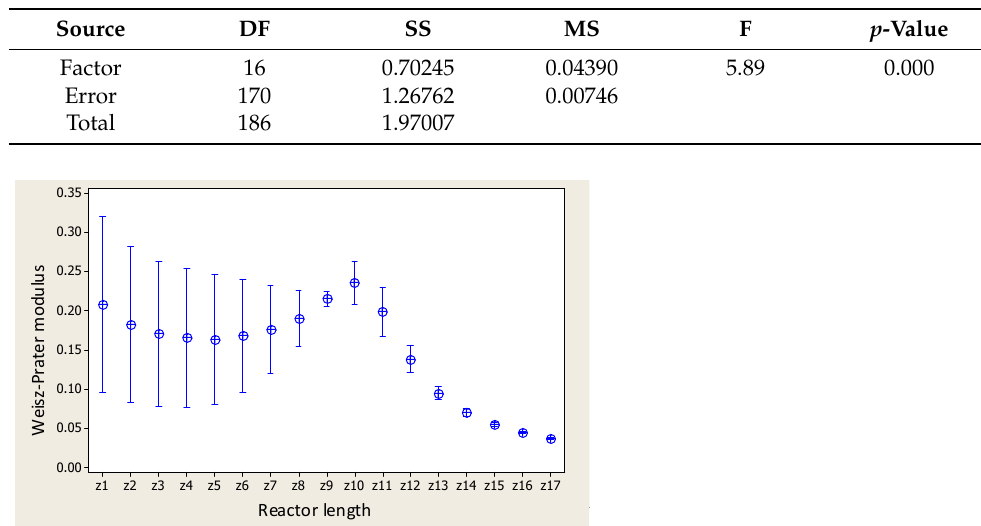
Table 7. Analysis of variance of the Weisz–Prater modulus versus the reactor longitude.